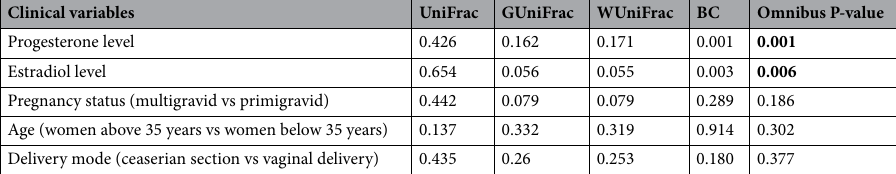
Table 3. Results from PERMANOVA-based omnibus test combining different distance metrics comparing the association between the vaginal microbiota and clinical variables. Significant p-values are depicted in bold